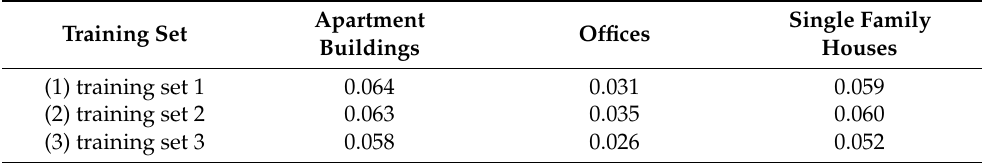
Table 2. NRMSE in the test set for different building